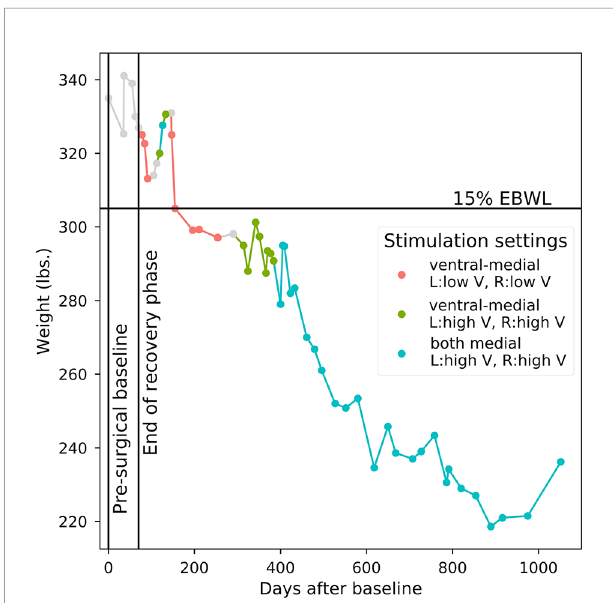
FIGURE 1 | Weight progression. Starting point is 335 lbs. at the pre-surgical baseline. Points correspond to individual weight measurements. Line colors correspond to the long-term device settings that were active in the period of time prior to each weight measurement. OTHER: Points 1 – 6 include pre- surgical baseline and post-surgery recovery when no stimulation occurred; stimulation parameters could not be veri fi ed between points 14 and 15 and between points 20 and 21; insuf fi cient titration and long-term data for evaluating active stimulation parameters between points 9 and